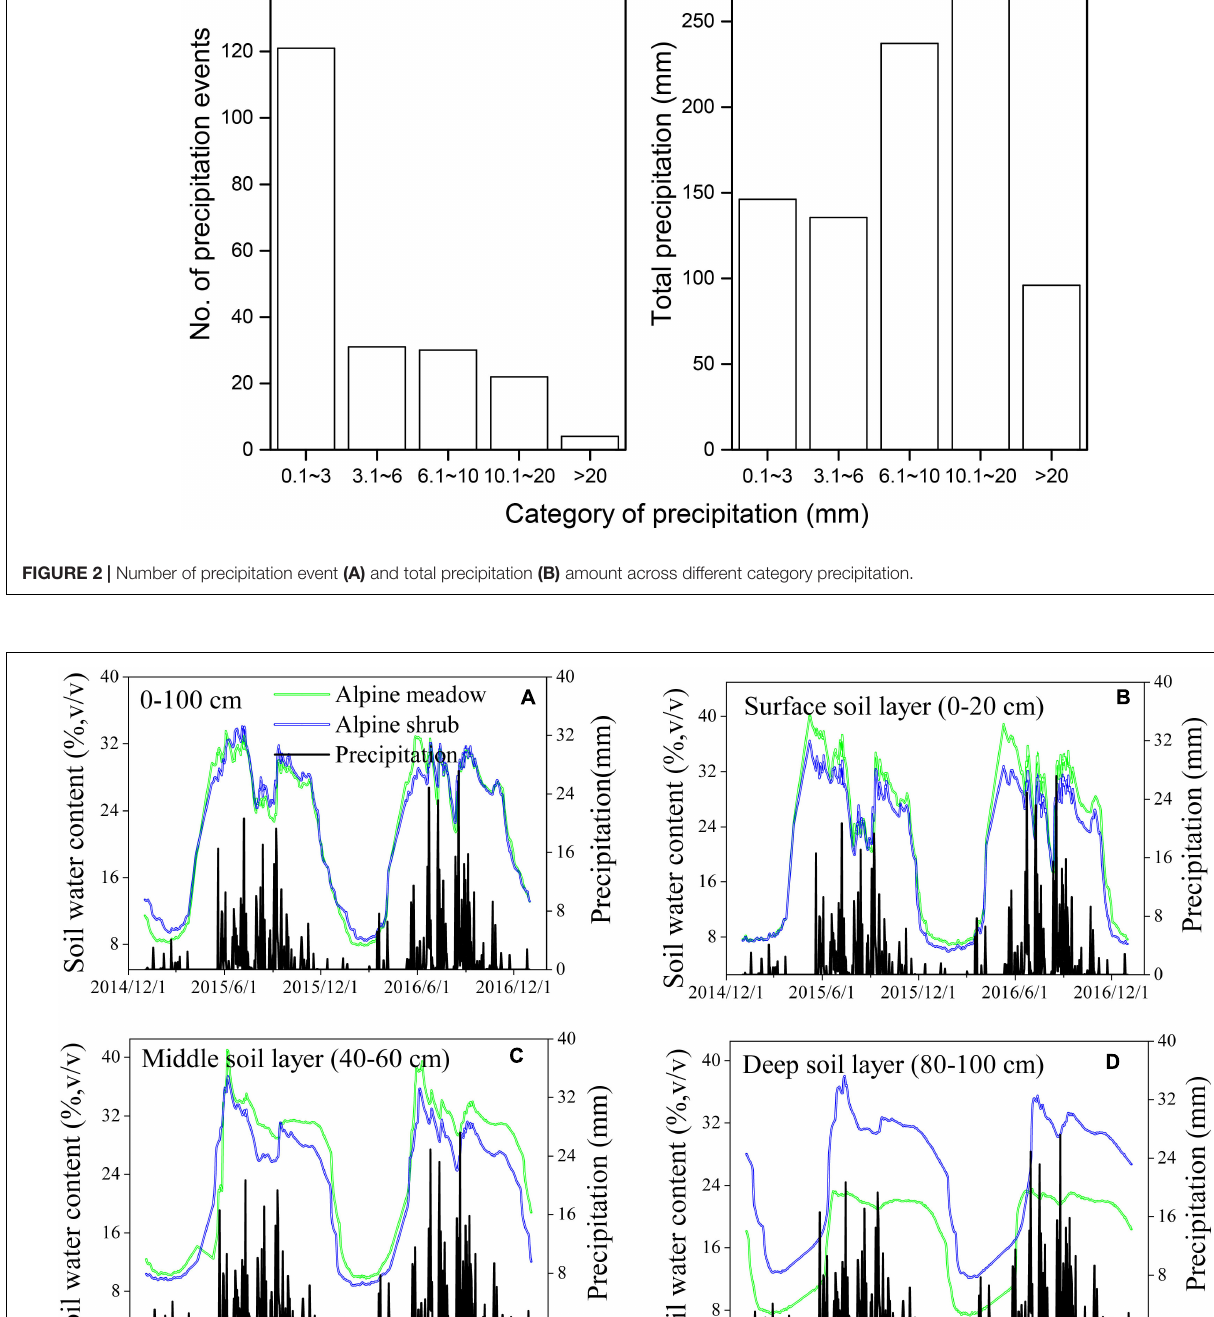
Frontiers in Plant Science |